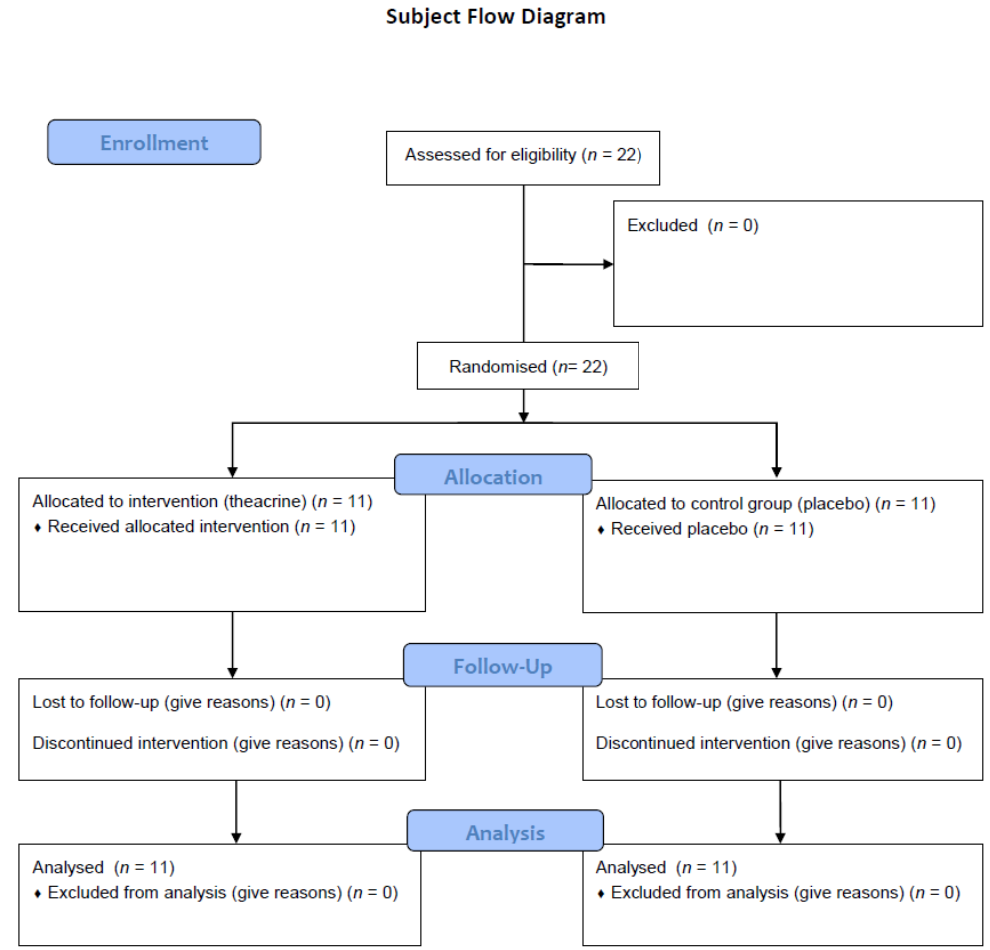
Figure 1. Subject flow diagram.